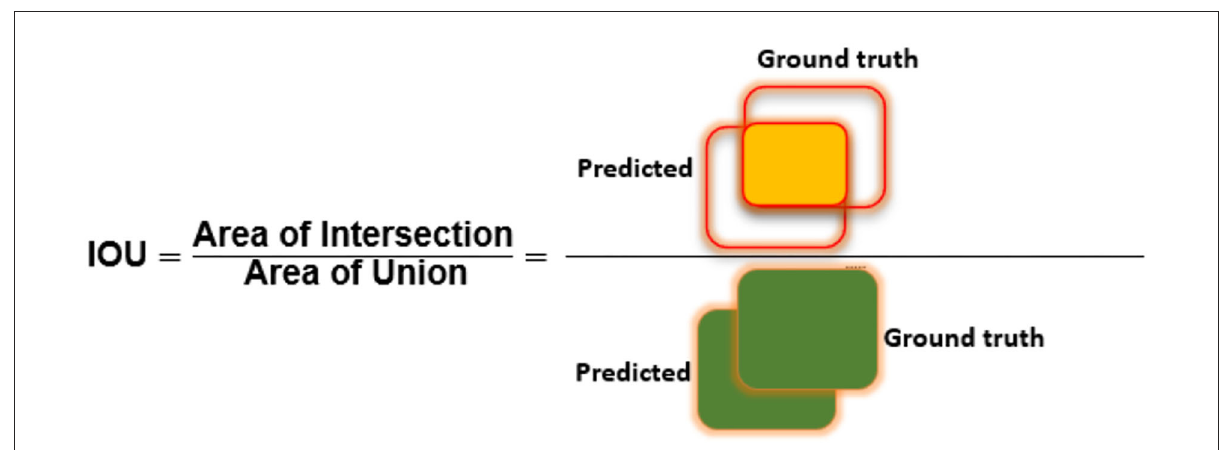
FIGURE5 Samples images of NIH CXR dataset.